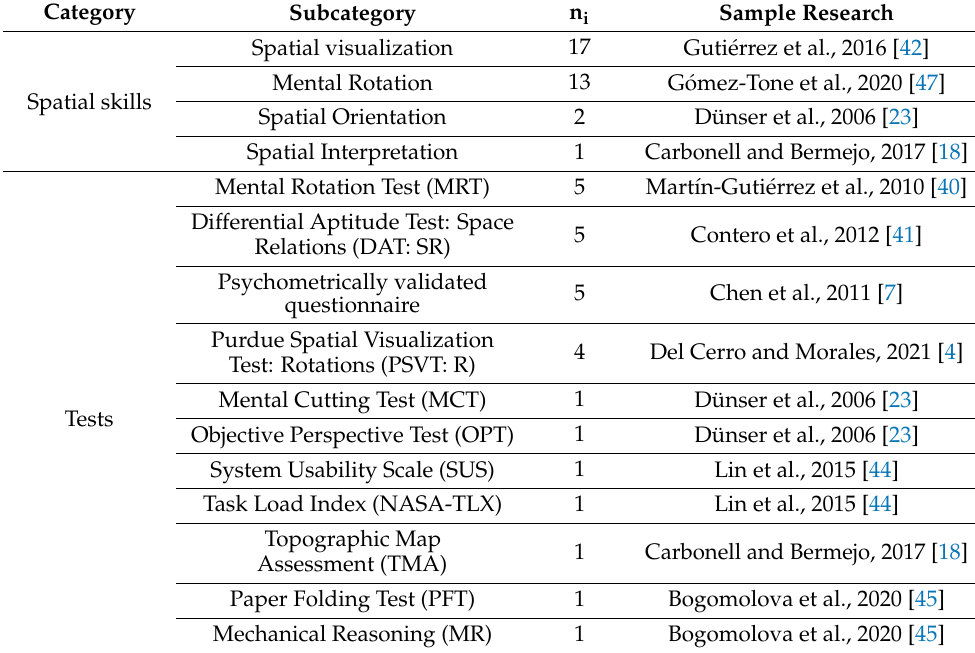
Table 7. Assessment of spatial